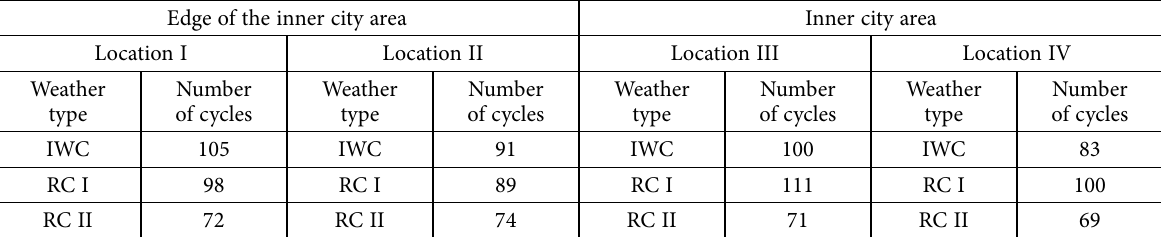
Table 1. Analysed weather types and sample of cycles per locations Edge of the inner city